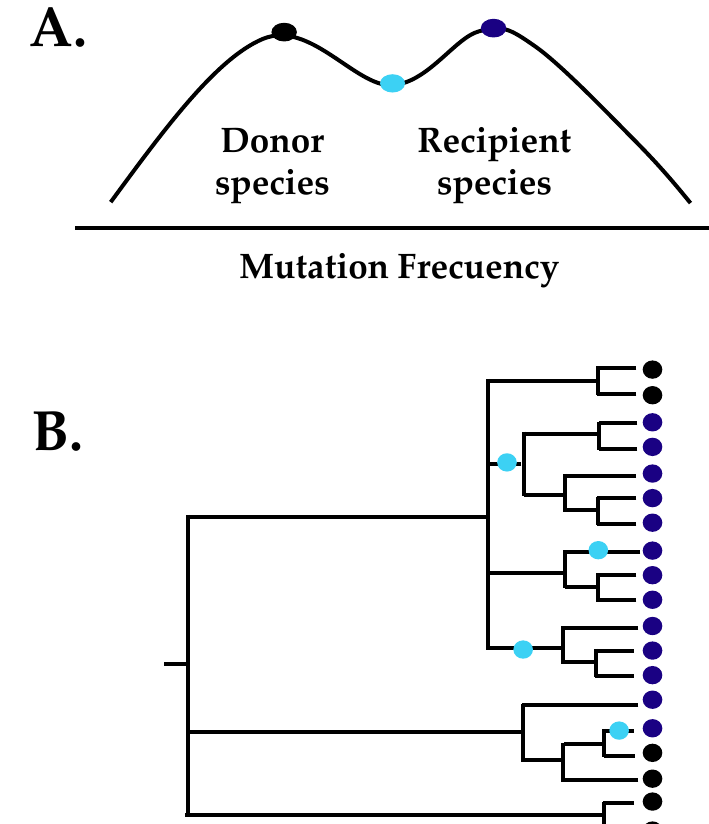
Figure 1. Evolutionary model for cross-species transmission of canine distemper virus (CDV). In the model, each peak represents the optimized viral fitness in a given host species, and specific mutations (colored circles) are essential to reach this optimum in the new host. ( A ) The two fitness peaks of CDV are separated by a shallow fitness valley, thus few adaptive mutations are required. One mutation allows the infection of other species but also decreases the fitness in the donor species (light blue circle, generalist trait). Coevolution with the new species can select for further mutations that optimize the fitness (dark blue circle, specialist trait). ( B ) CDV infection in canids and non-canids as an example of the model presented in ( A ). A simplified phylogeny of the H gene showing the relationships between CDV strains from canid and non-canid hosts, indicated at the tip of the tree as black and blue squares, respectively. The distribution of the amino acid site 549, which has been shown to be involved in CDV infection in non-canid hosts and is under positive selection, is mapped onto the branches of the tree. Commensurate with the coloring in panel ( A ), the substitution of site 549 is shown in light blue because it is considered a generalist trait that permits the infection of various non-canid species, but with lower fitness than the specialist trait in canids, marked in